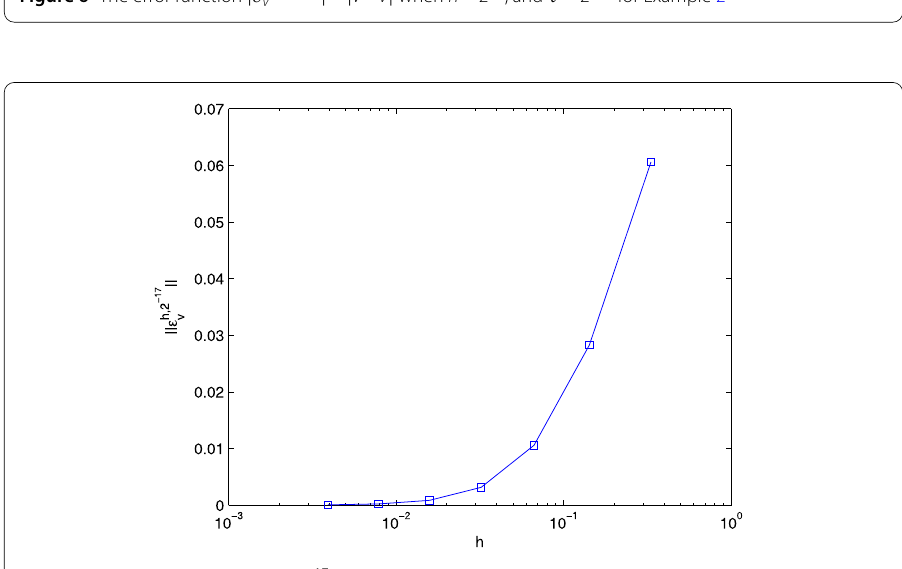
Figure 7 The maximum errors (cid:7) ε h